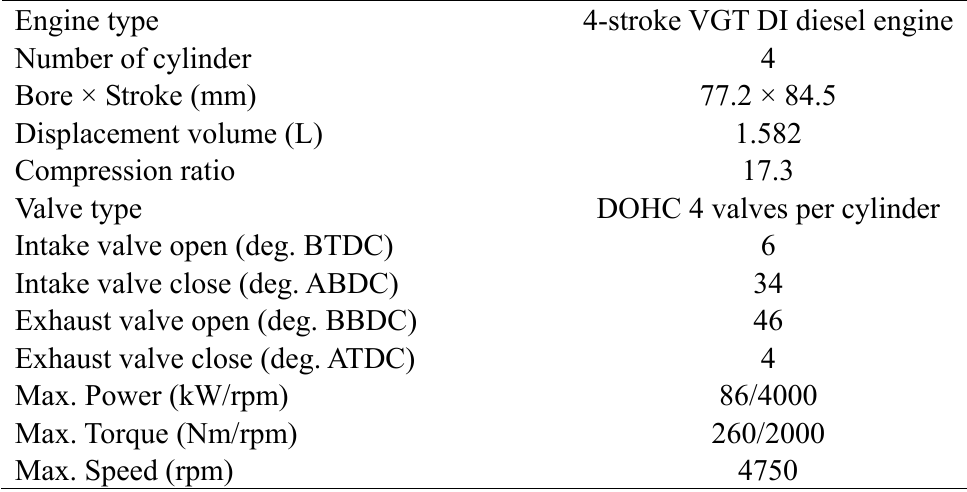
Table 1. Specifications of the test